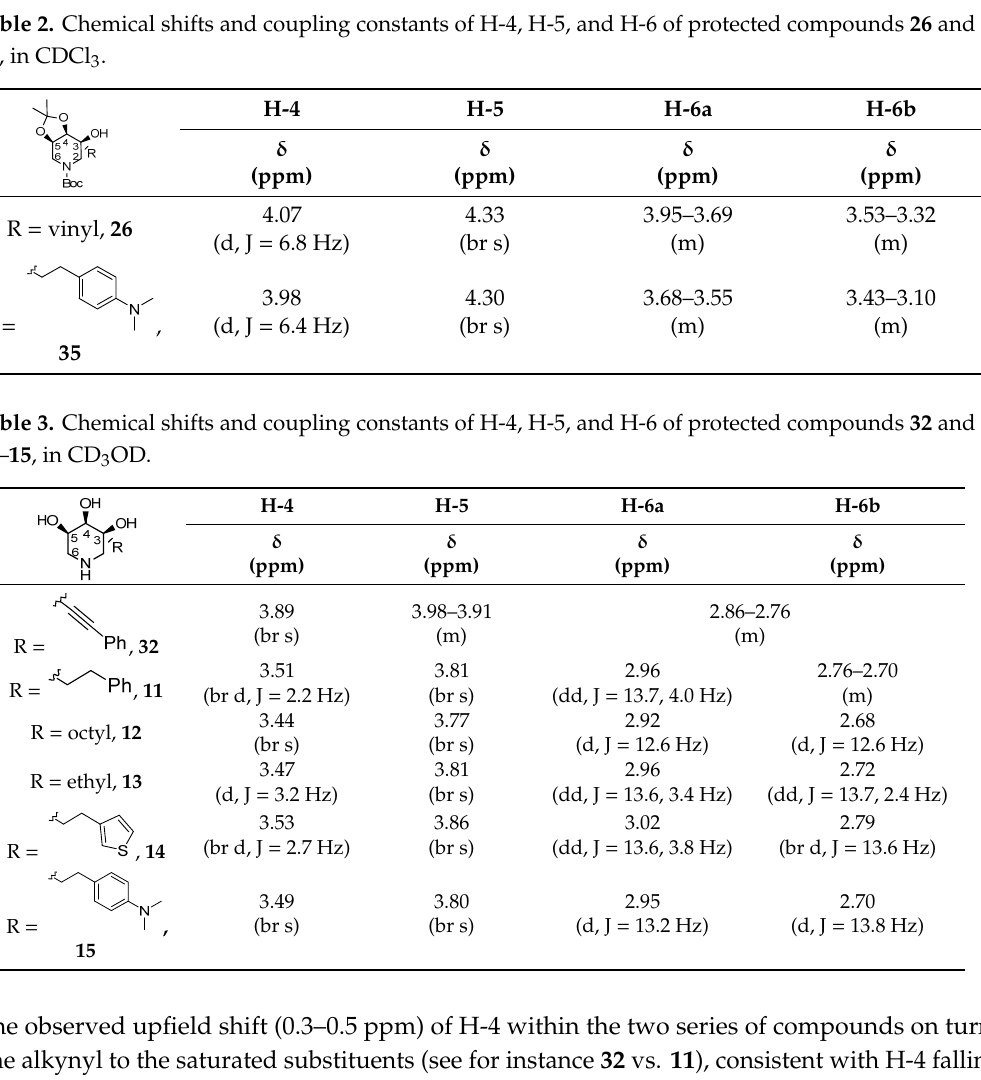
Table 2. Chemical shifts and coupling constants of H-4, H-5, and H-6 of protected compounds 26 and 35 , in CDCl 3 .